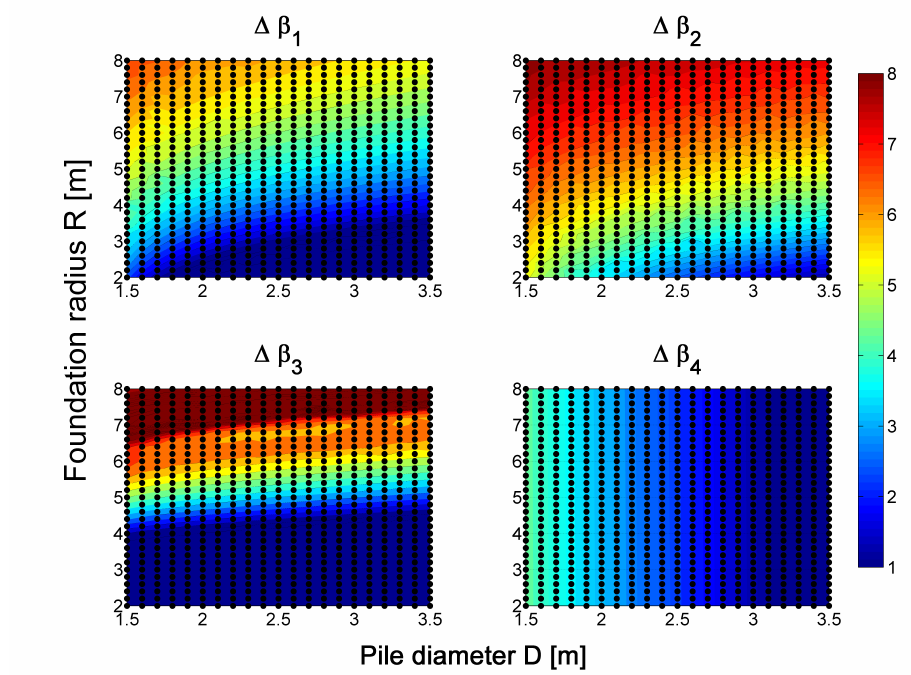
Figure 4. Reliability indices behavior for the four considered failure modes and different pile diameter and foundation radius values of Case 3. ∆ β : annual reliability index sliding 1 foundation; ∆ β : annual reliability index overturning of device; ∆ β : annual reliability 2 3 index bearing capacity failure; ∆ β : annual reliability index bending failure pile. 4